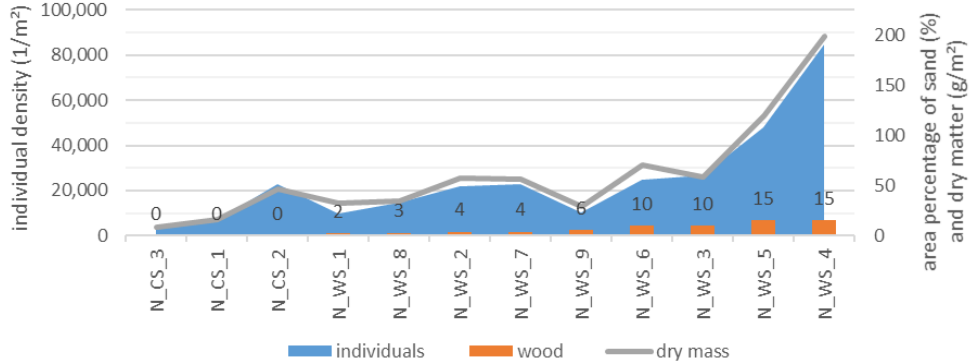
In Nieplitz, individual density and dry matter per m 2 increased with increasing pro- portion of wood (Figure 9). Both relationships show a high correlation. The correlation coefficient for the MI individual density as a function of wood was 0.73 and that of the Figure 8. Individual density and dry matter in g per m 2 depend on the area percentage of sand and Figure 8. Individual density and dry matter in g per m 2 depend on the area percentage of sand and dry matter 0.72 ( p < 0.05). detritus (%) of WS and CS in Ihle (I) stream sorted according to the proportion of sand. detritus (%) of WS and CS in Ihle (I) stream sorted according to the proportion of sand.